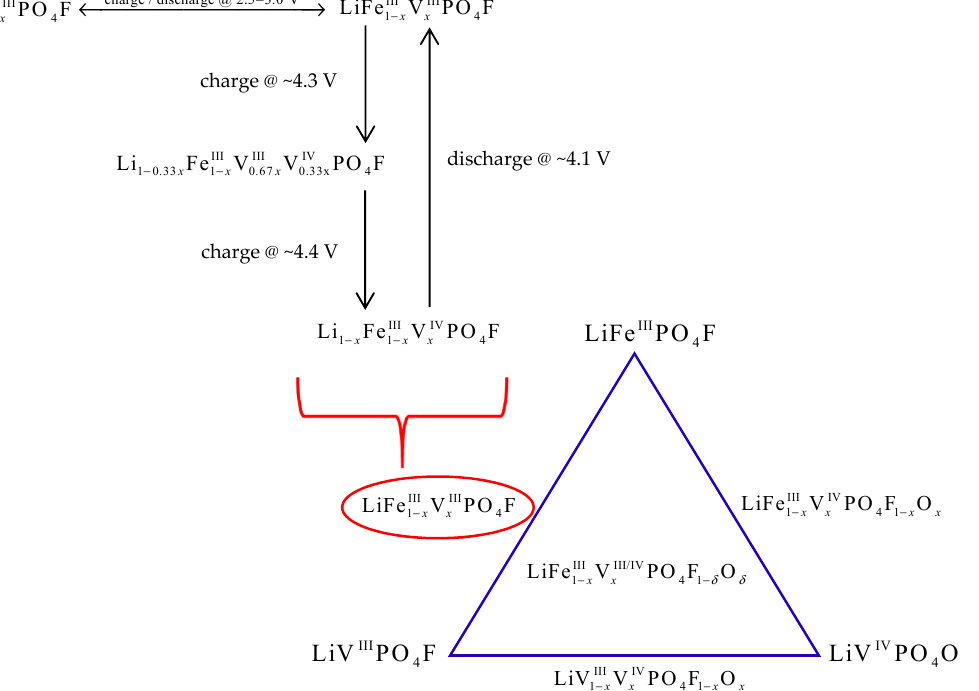
Figure 6. Total reactions in LiFe 1 − x V x PO 4 F (0 ≤ x ≤ 1) cells.